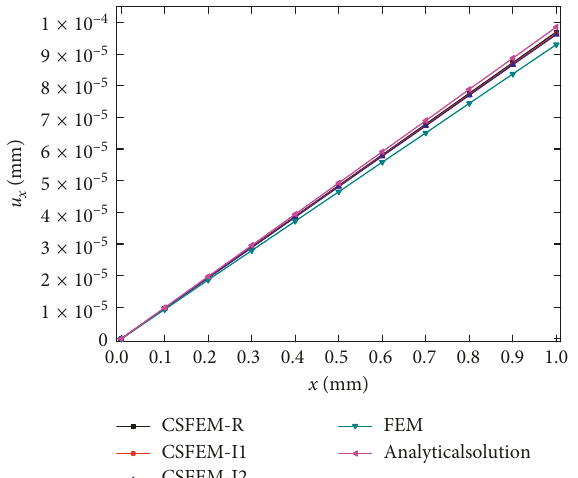
Figure 9: Variation of electric potential of the singer-player PCMs strip.